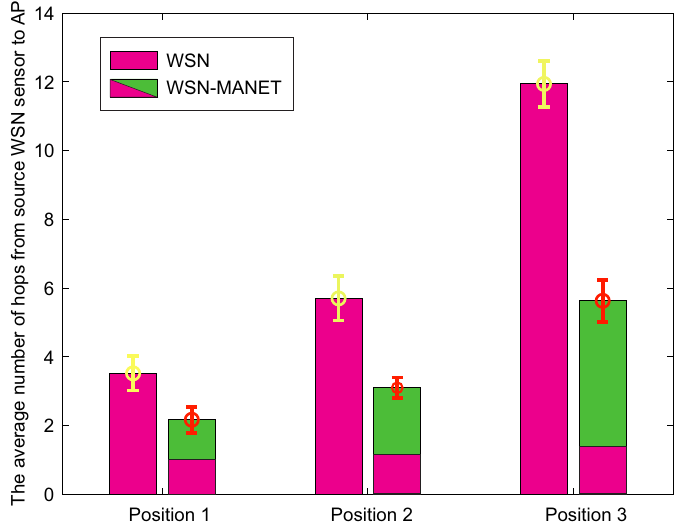
Figure 20. The average number of hops from source WSN sensor to